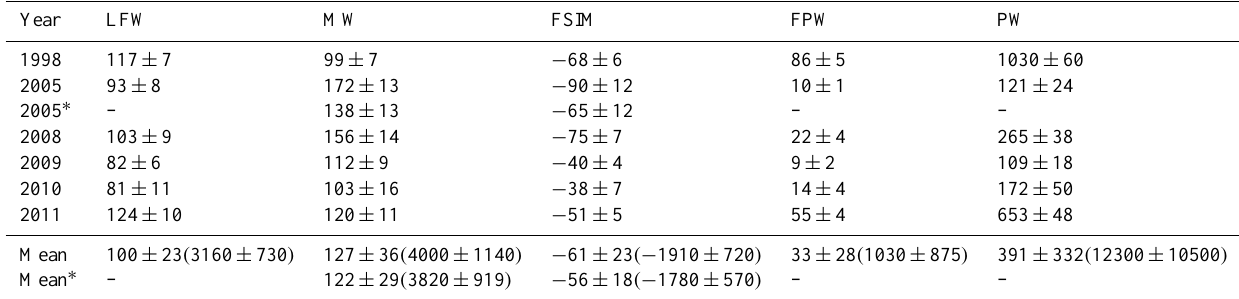
Table 4. Observed volume transports of LFW components between 10.6 ◦ W and 4 ◦ E for each year. Transport values are given in mSv; in addition, mean values in “()” are given in km 3 yr − 1 . Negative FSIM transports represent positive FIFB transports. Transport errors are also given. These incorporate both errors from the inverse volume transports and from the fractions from the end-member equation. The combined errors from the inverse and the end-member equations for LFW components are discussed in Sect. 2.5. The errors for each transport and survey are almost the same as the error from the inverse estimate, with the exception of FPW and PW transports; here, the error shown is about twice the error from the inverse estimate alone. There is a potential overestimate of MW transports and underestimate of FSIM transports in 2005 by about 20% and 28,%, respectively, due to the reconstruction of δ 18 O values from salinity data (see Rabe et al., 2009). This is denoted by the transport values on the line starting with 2005 ∗ . The mean transports are the arithmetic mean of all surveys for each water mass. For 2005, the estimate including the potential bias is also given. The errors of the mean transports for each quantity are here represented by the the mean of the corresponding transport errors from all surveys and the variability of the transports between surveys (twice √ the standard error of the mean, i.e. twice the standard deviation divided by 6, where the latter is due to the number of surveys; this error gives a 95% confidence